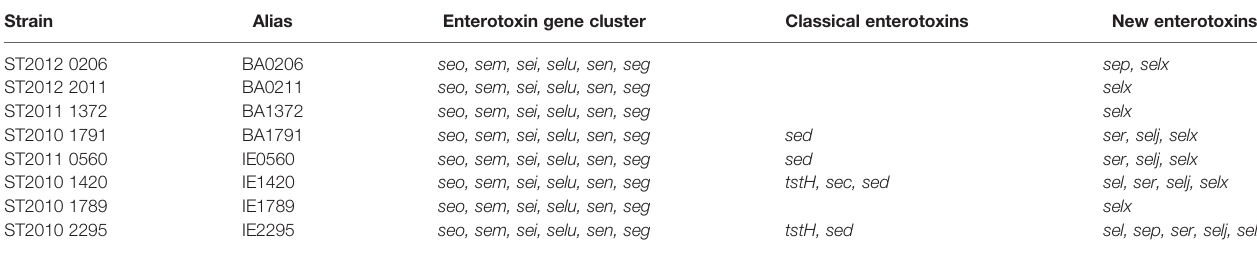
TABLE 1 | Staphylococcus aureus strains tested from CC5 lineage.